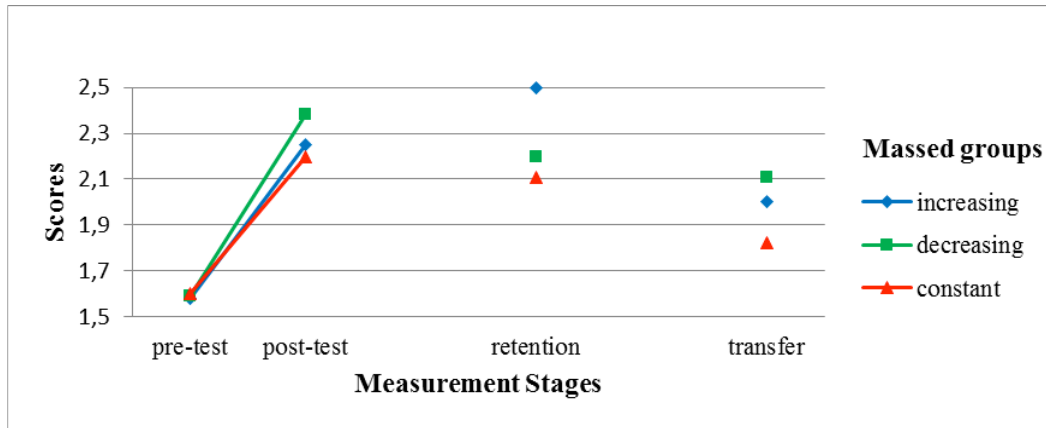
Figure 1. The mean of scores in various stages of measurement in massed practice groups.